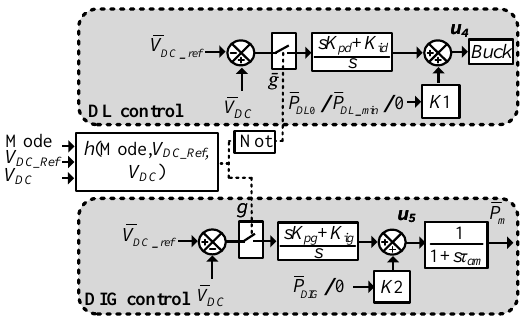
Figure 8. Diagram of the control loops added to the DIG and DL for the DC-link voltage regulation.